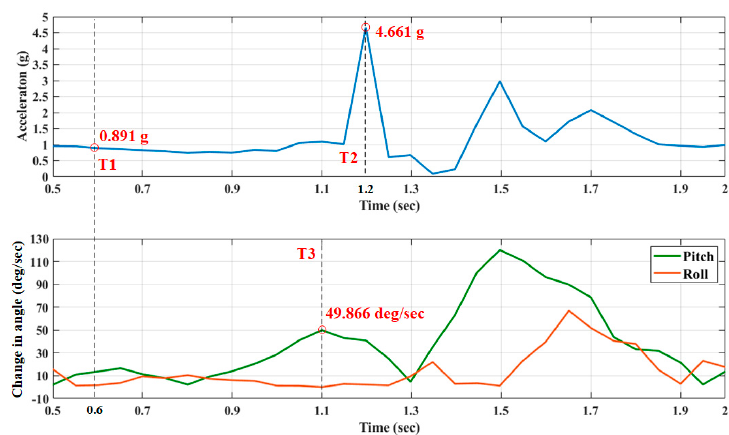
Figure 4. RMS acceleration and change in pitch and roll angles during a fall with marked points at which events are detected with associated timestamps.